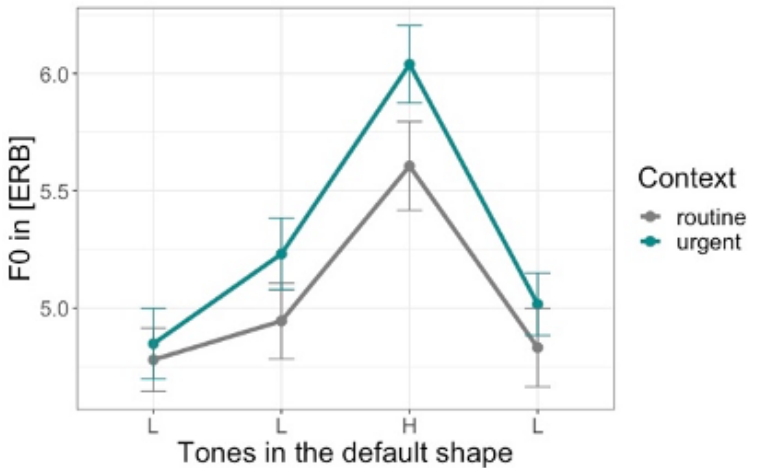
Figure 11. F0 scaling of the default contour in the routine and urgent context for four syllabic words with L L H L lexical tones in CF.